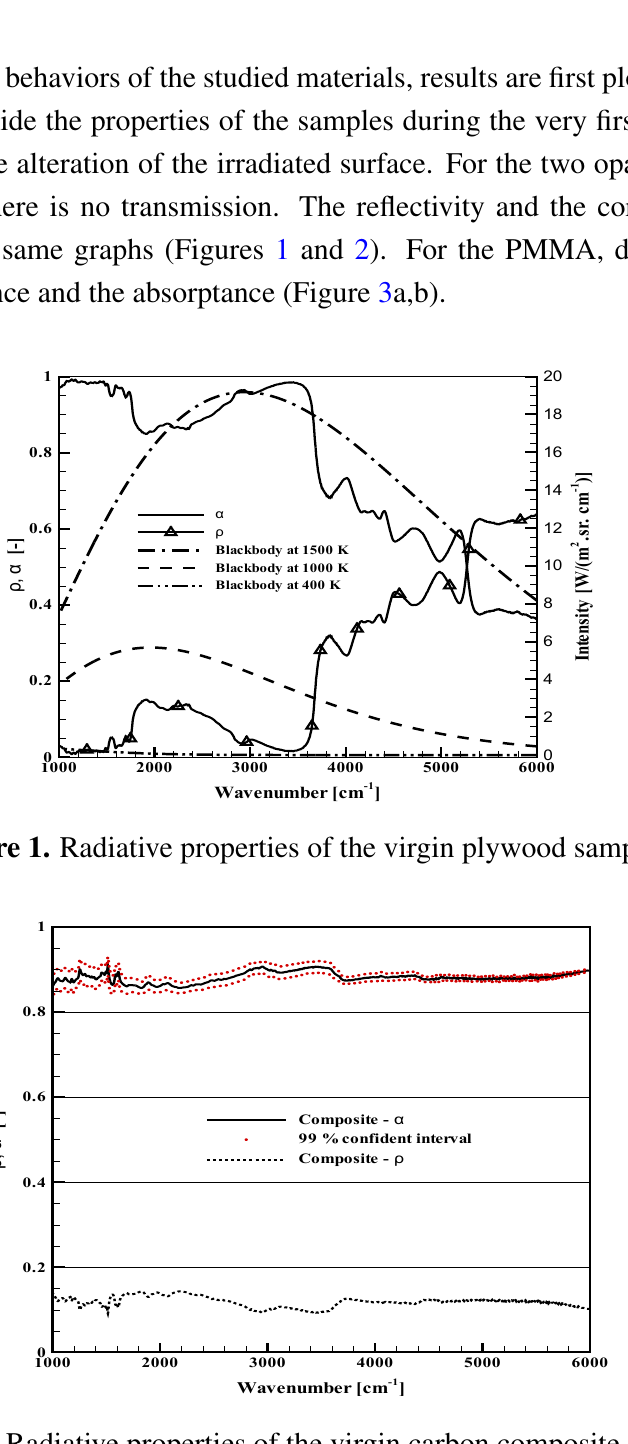
Figure 2. Radiative properties of the virgin carbon composite